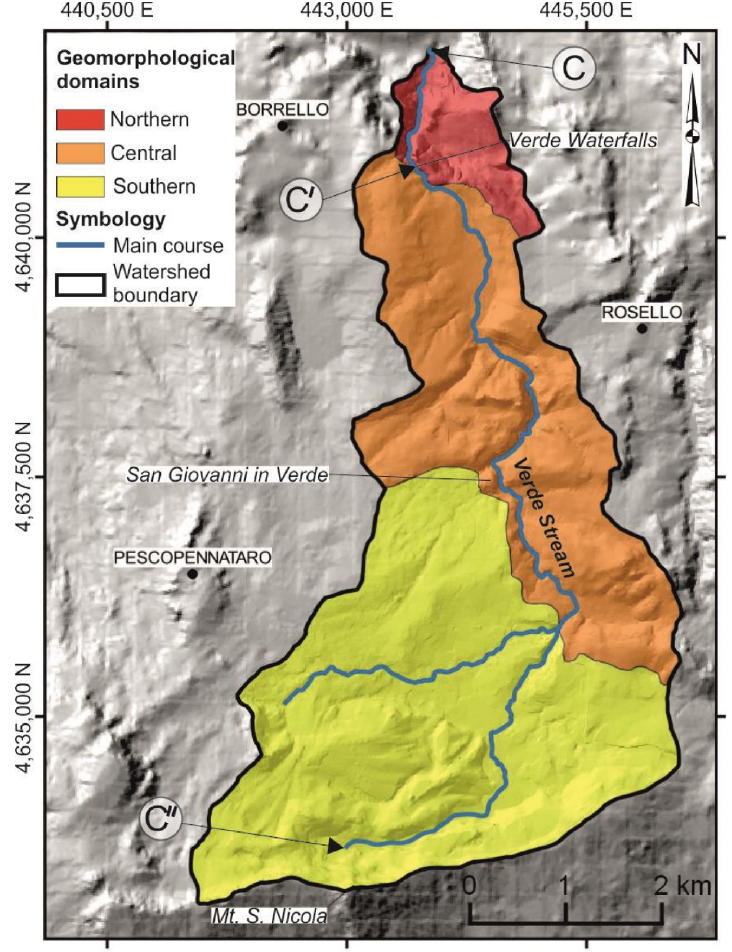
Figure 14. Geomorphological domains of the study area, on which different morphosculptural processes took place (location of letters C, C’, C” in Figure